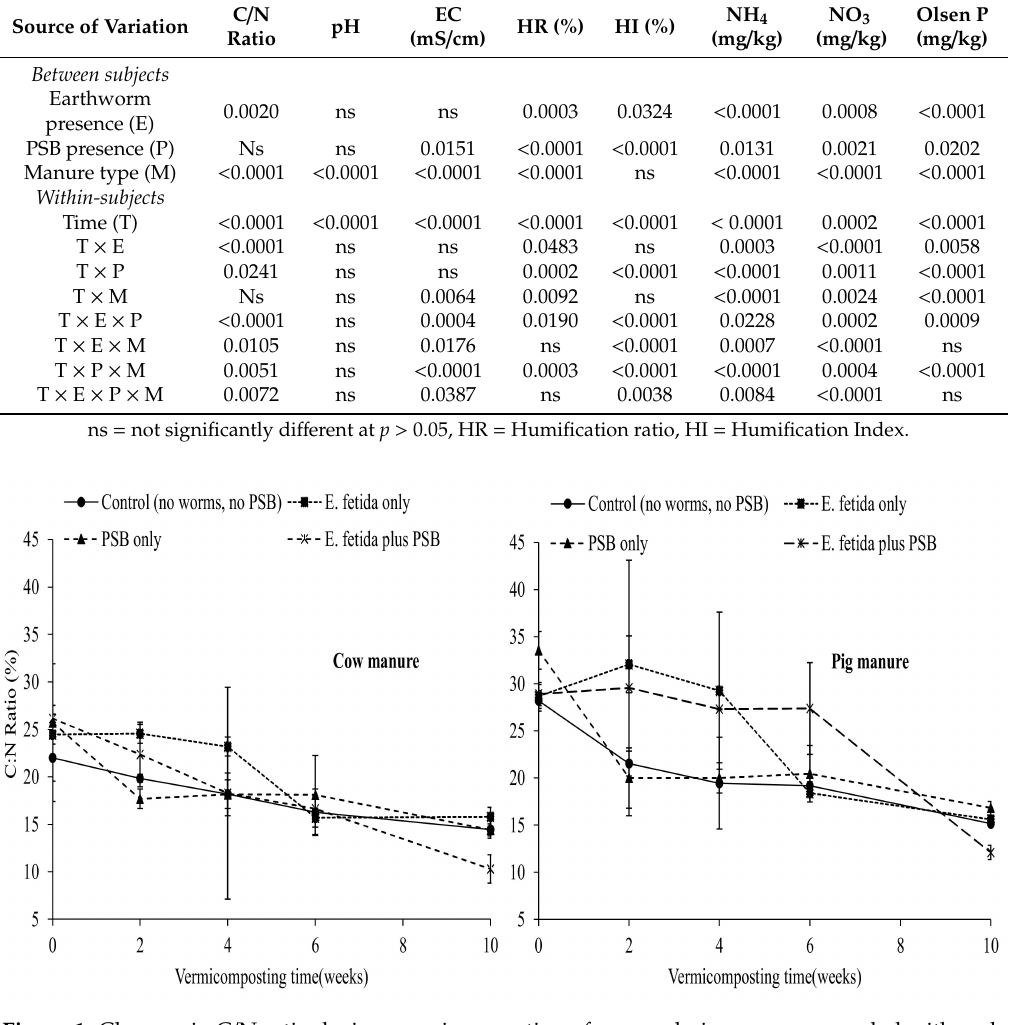
Figure 1. Changes in C / N ratio during vermicomposting of cow and pig manure amended with rock phosphate and P. fluorescence . Error bars indicate standard